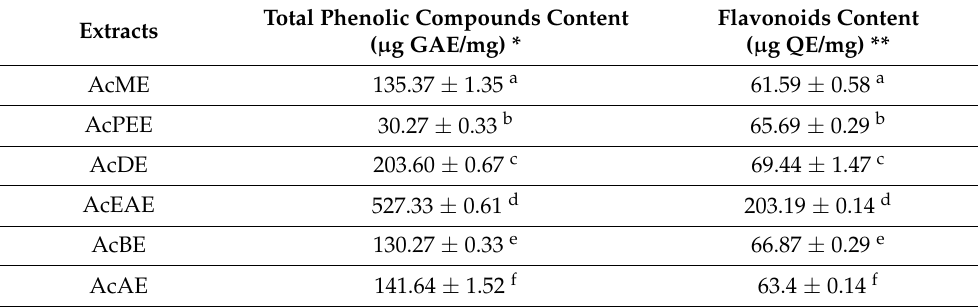
Table 4. Total phenolics, flavonoids contents of differences extract of A. campestris .